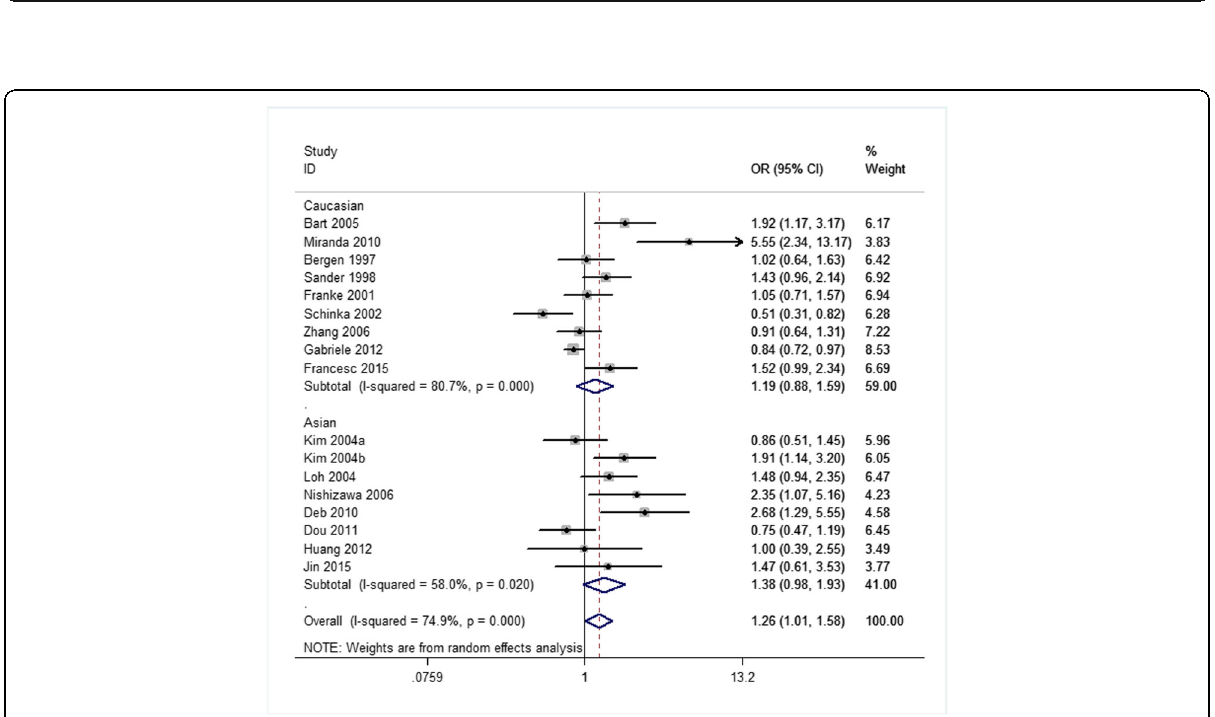
Fig. 5 Forest plots (individual and pooled effects with 95% CI) regarding the association of the OPRM1 A118G polymorphism with alcohol dependence in the heterozygote model